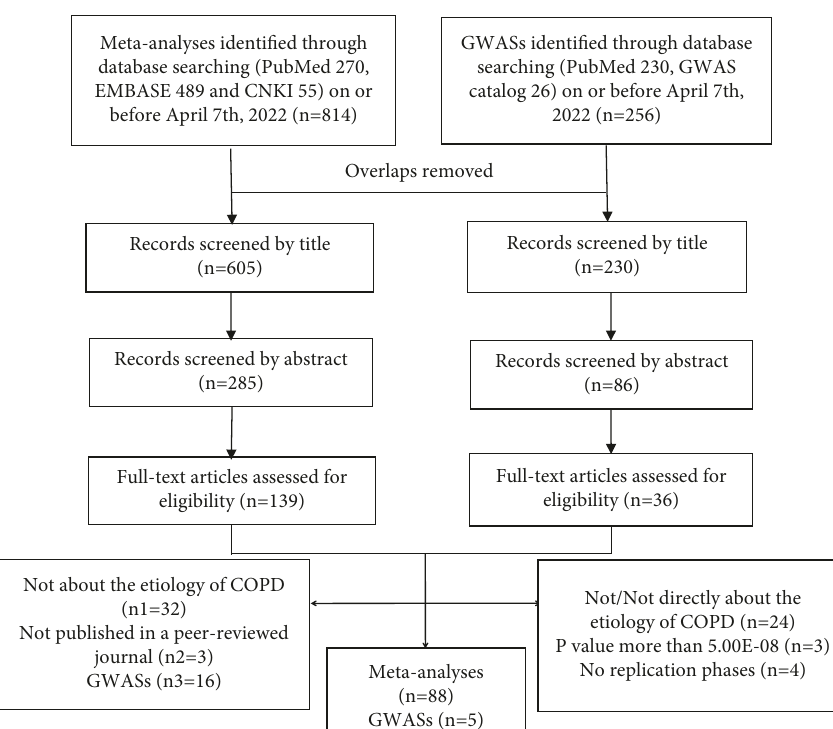
Figure 1: Selection of